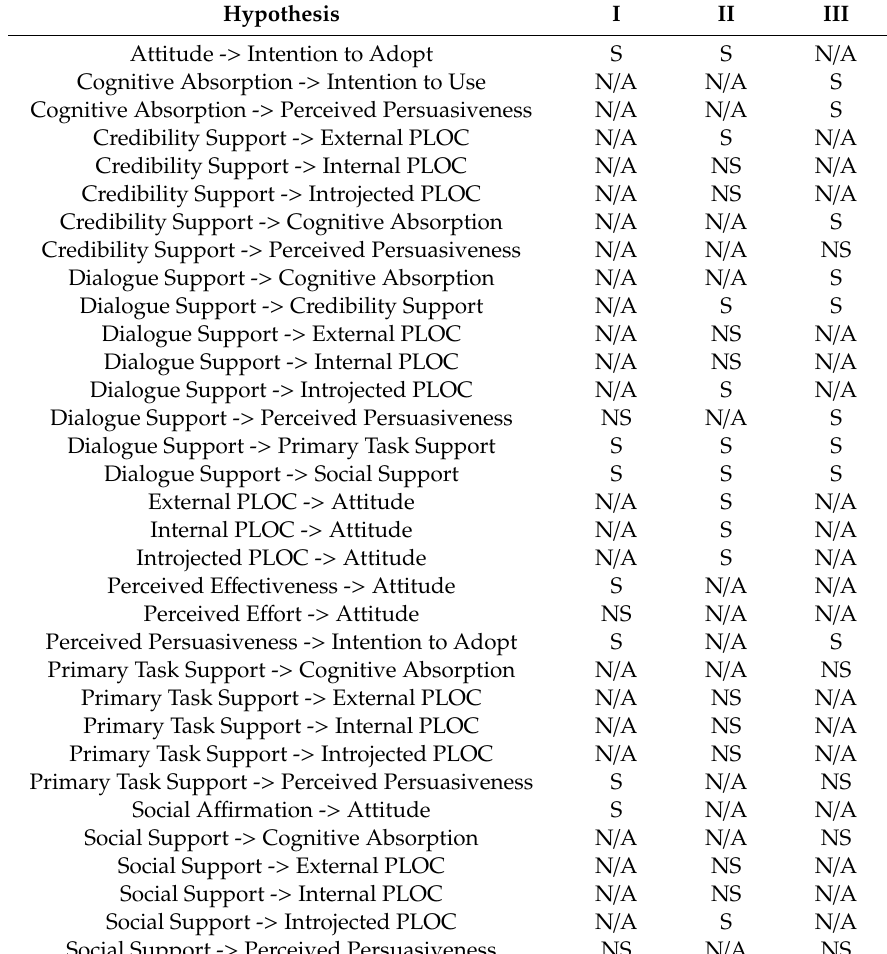
Table 3. Summary of the hypotheses in Studies I–III 1 .